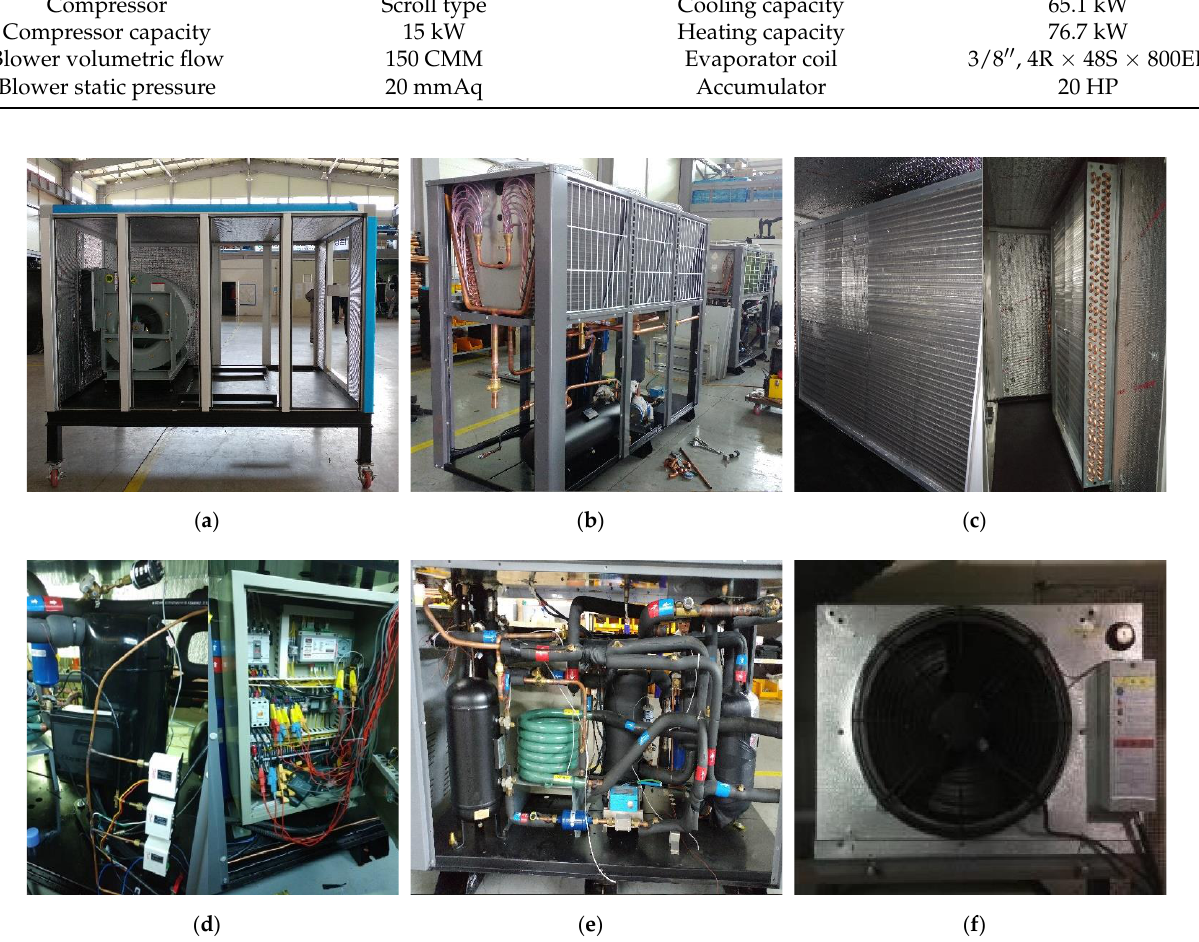
Figure 5. ( a ) Air conditioner frame, supply fan; ( b ) Outdoor condensing coil; ( c ) Air conditioner coil; ( d ) Compressor, control panel; ( e ) Air conditioner unit piping connection; ( f ) Cooler for the outdoor unit.